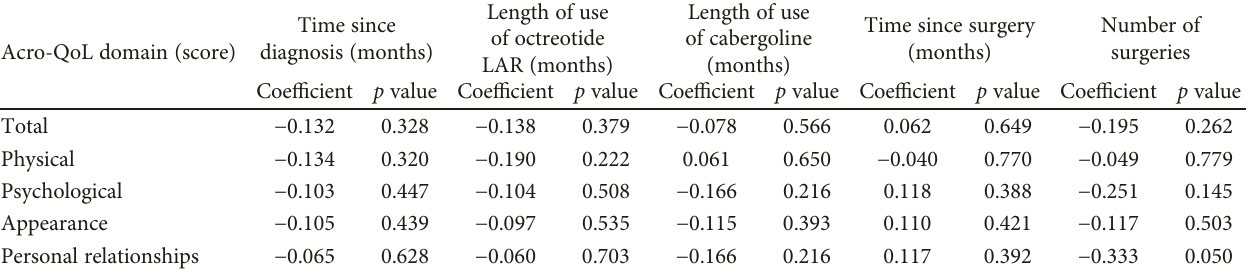
Table 6: Correlation between the Acro-QoL domain scores and the disease diagnosis and treatment variables, São Luís, state of Maranhão, Brazil,